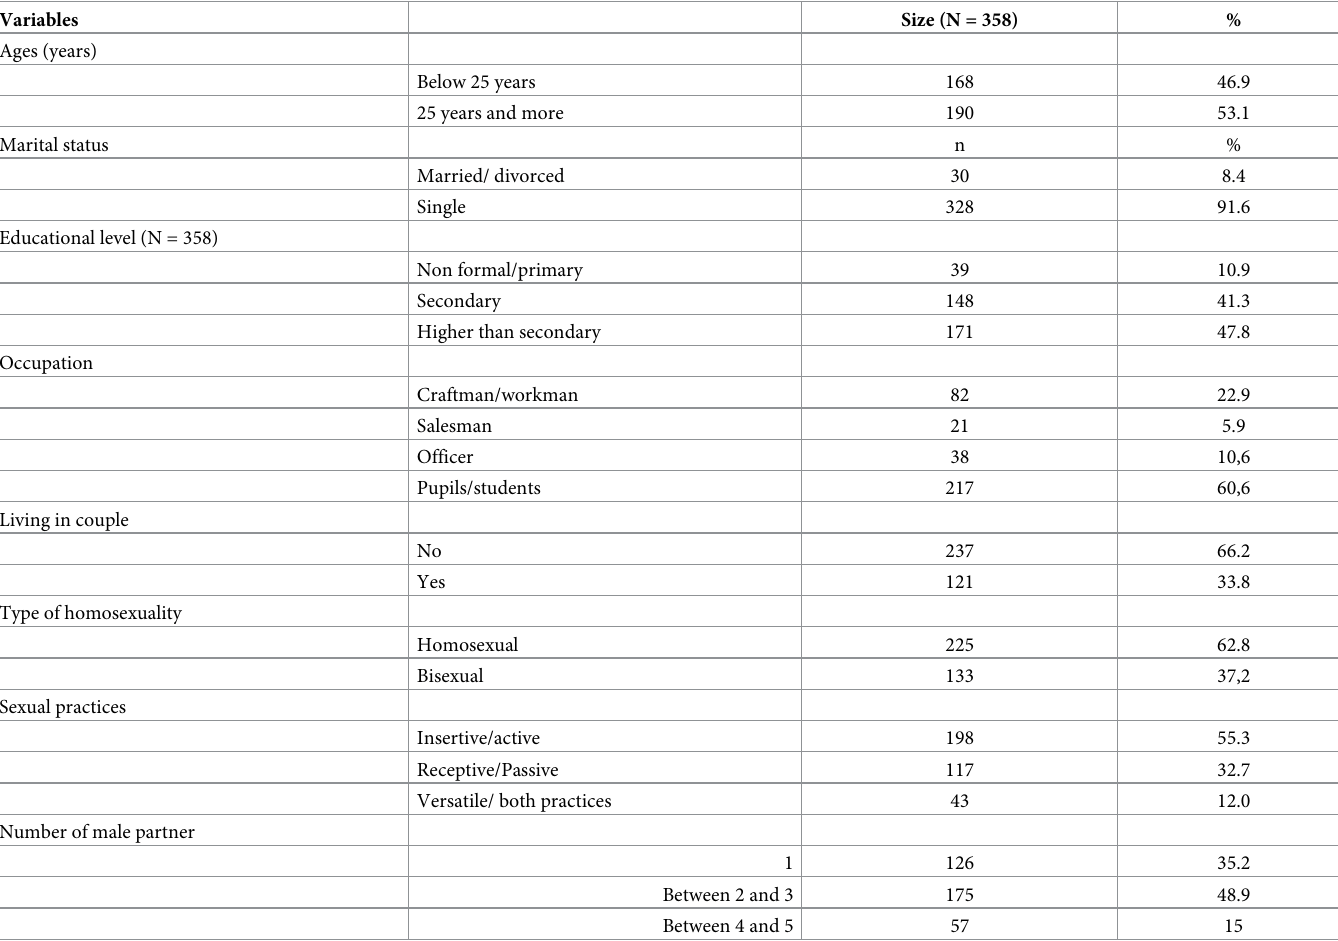
Table 1. Number and percent distribution of men who have sex with men (MSM) by socio-demographic characteristics, age, marital status, education, occupation, living in couple, type of homosexuality, sexual practices, number of male partners, Benin